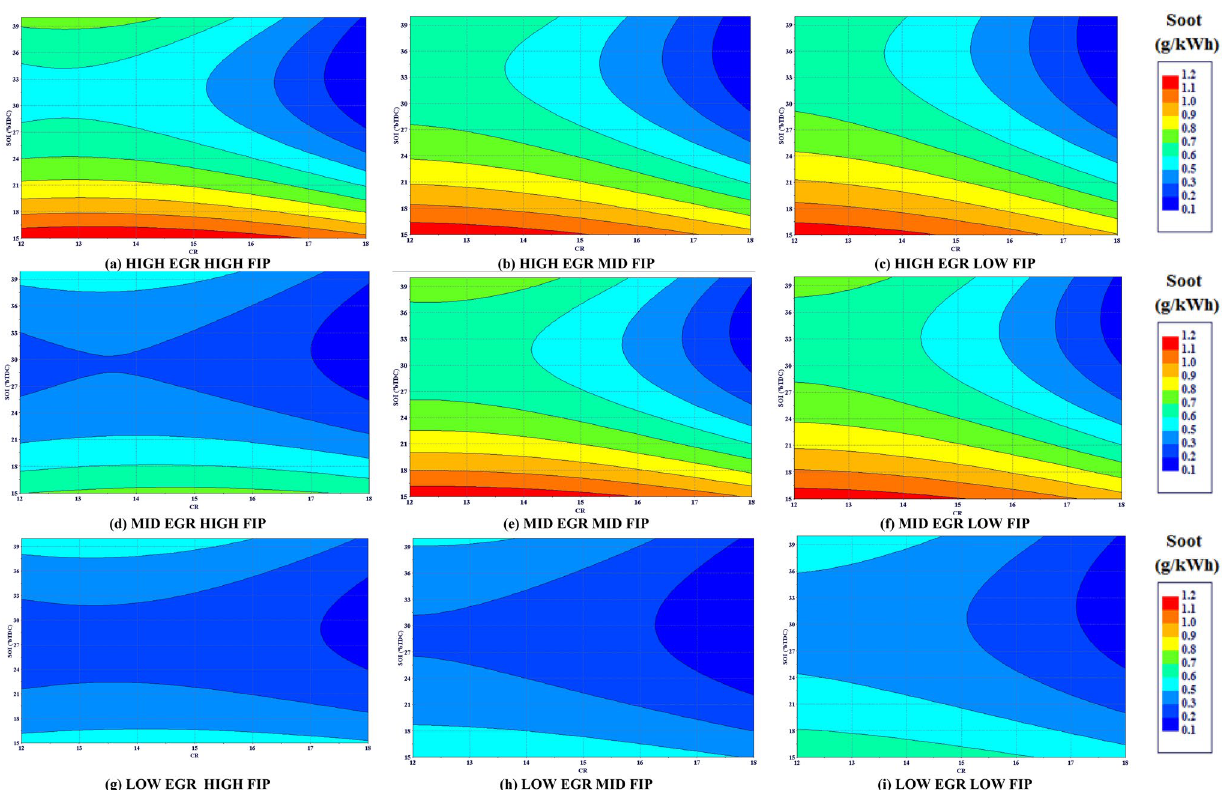
Fig. 5 Contour plots of soot for SOI and CR at different levels of FIP and EGR (VCR DIESEL)